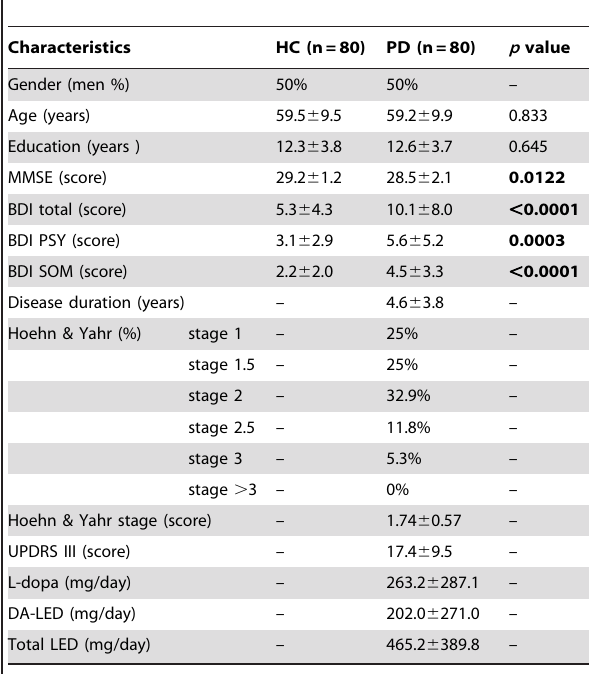
Table 1. Socio-demographic and clinical characteristics of HC and PD subjects.